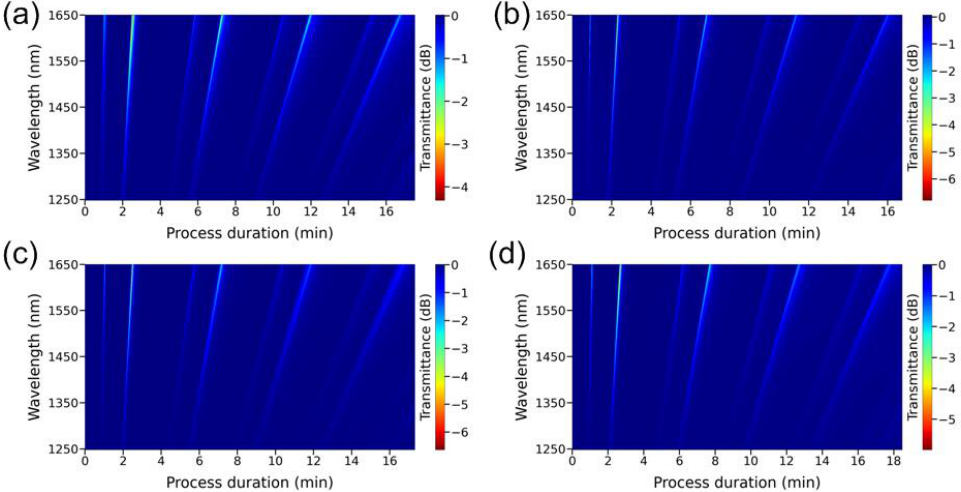
Figure 3. Spectral response in the wavelength range of 1250 – 1650 nm depending on the duration of the synthesis process of ZnTe film on the surface of a thinned optical fiber at the C Te /C Zn ratio equal to: ( a ) 1.13, ( b ) 1.38, ( c ) 1.49, ( d ) 1.80.